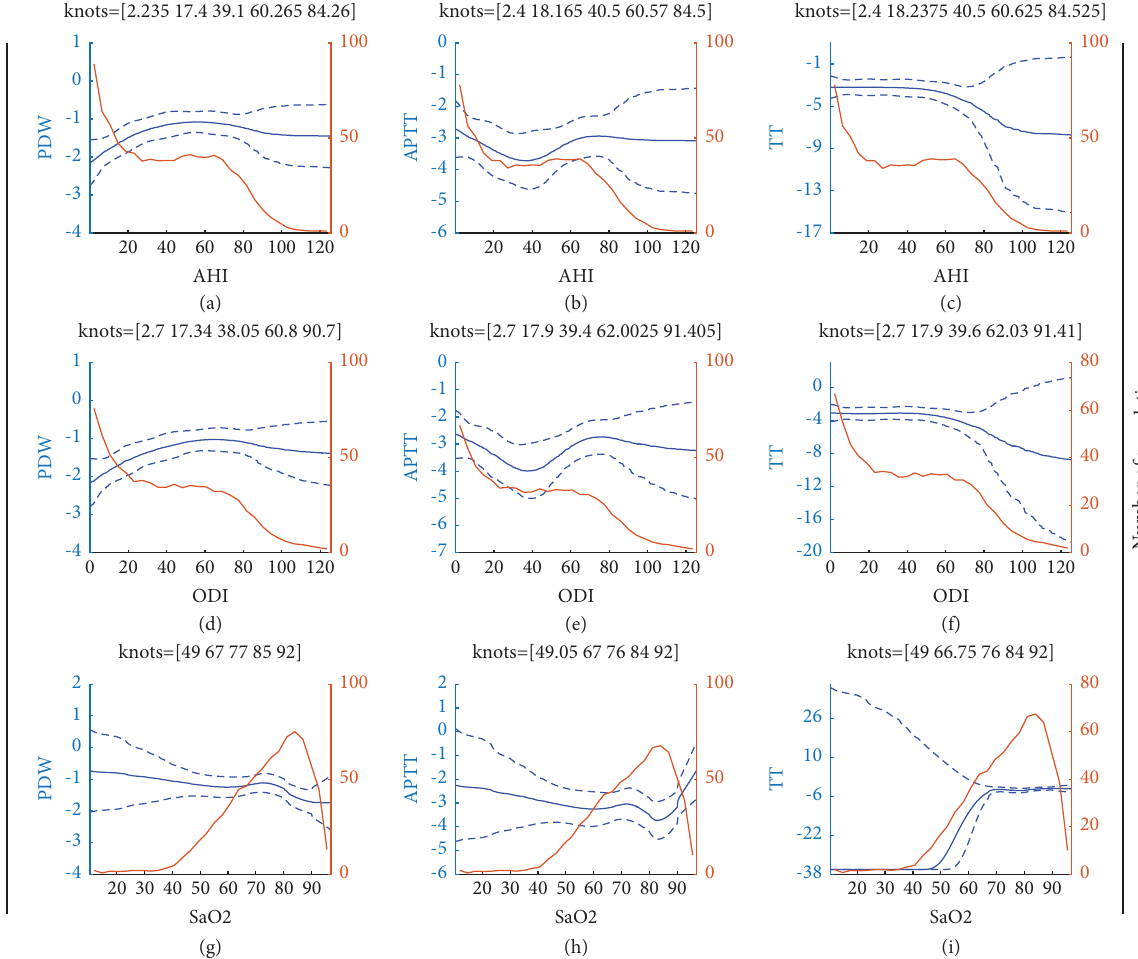
Figure 1: Restricted cubic spline regression of the nonlinear relationship between abnormal coagulation (including platelet distribution width (PDW), activated partial thromboplastin time (APTT), and thrombin time (TT) data) and the severity of obstructive sleep apnoea (OSA). Te x -axis represents the continuous values of the apnoea-hypopnea index (AHI), oxygen desaturation index (ODI), or arterial oxygen saturation (SaO 2 ). Te left y -axis represents the log odds of abnormal coagulation for each coagulation marker. Te right y -axis represents the number of